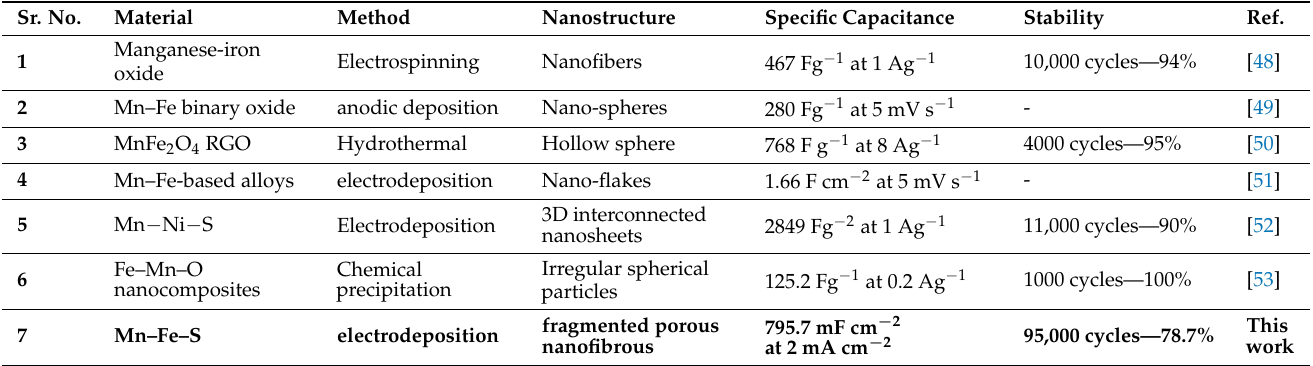
Table 3. Comparison of previous reports on Mn-Fe binary metal oxides and sulfides as an electrode material for supercapacitor with present